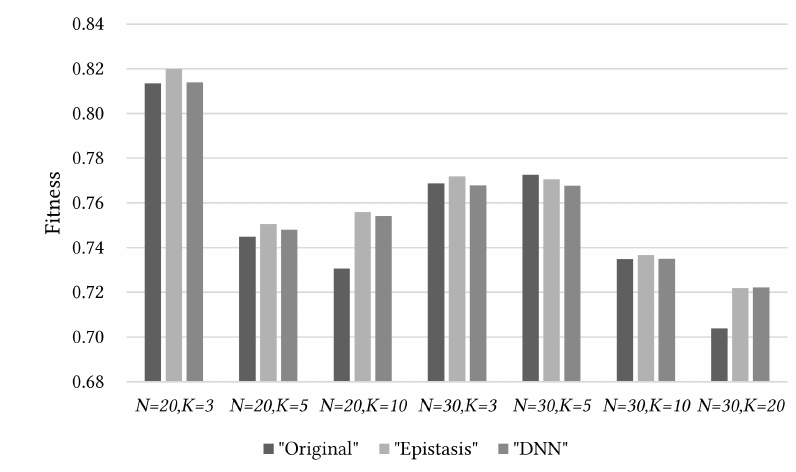
Figure 6. Performance comparison of the experiment in this study (“DNN”) and those in previous studies (“Original” and “Epistasis”) on the average of population for the NK -landscape problem.